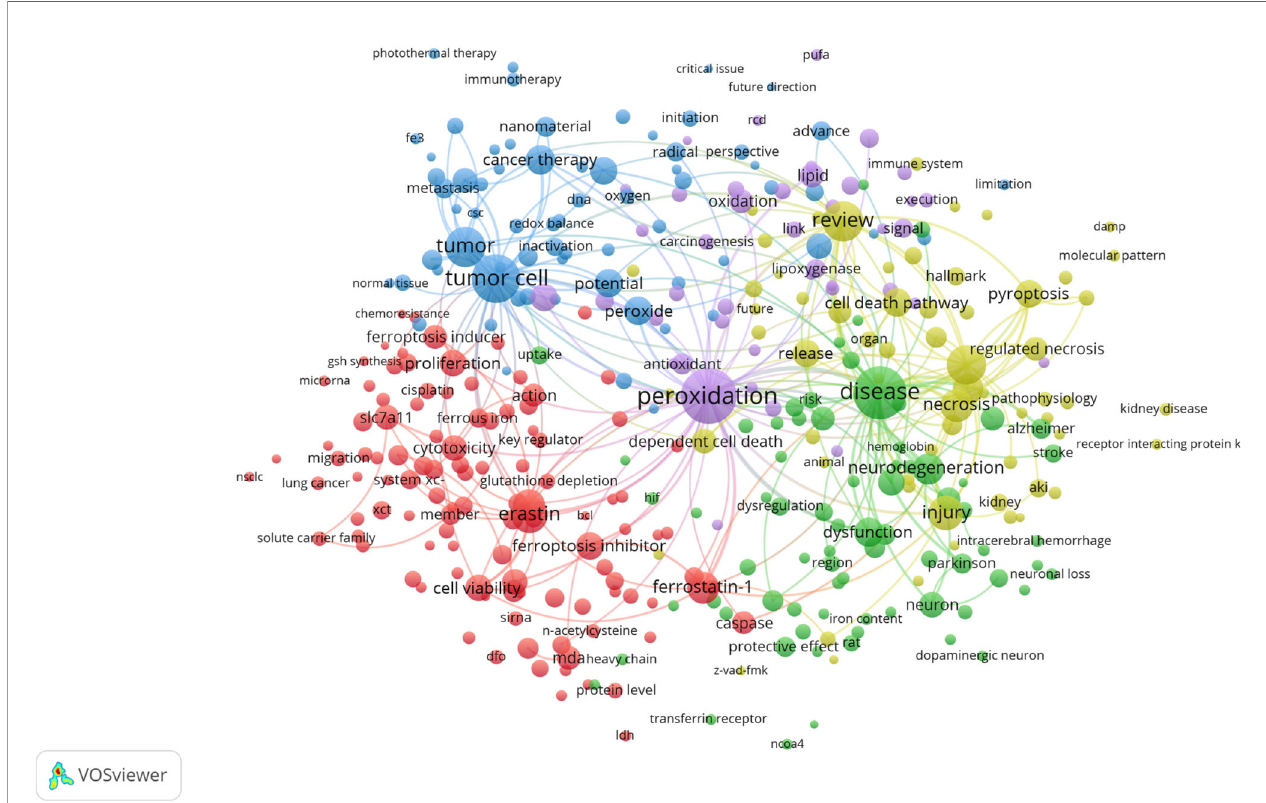
FIGURE 7 | Terms co-occurrence network and clusters in ferroptosis research (T ≥ 10, relevance score ≥ 0.081, contains 357 items, 5 clusters and 25,151links; max lines = 200.). Notes: The size of node and word re fl ects the co-occurrence frequencies, the link indicate the co-occurrence relationship, and the same color of node represent the same